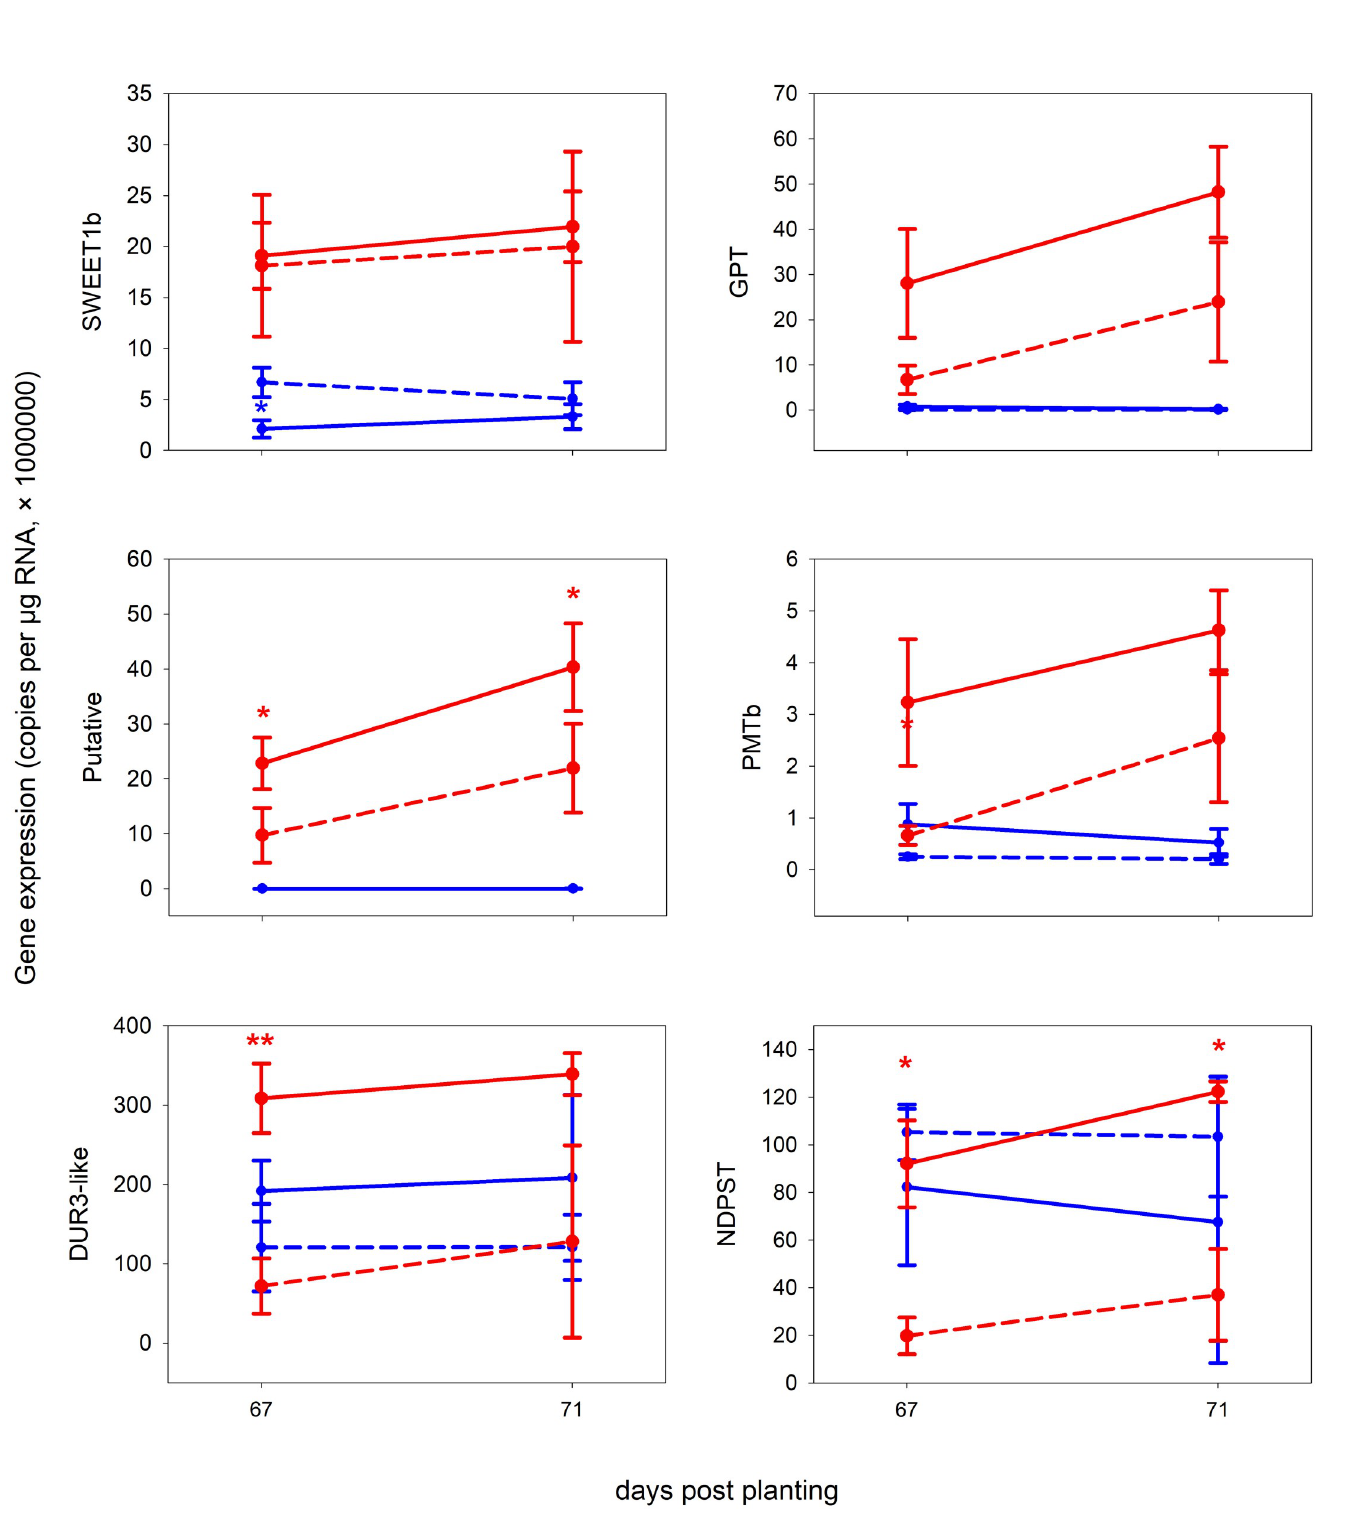
Fig 3. The expression of several genes obtained by qPCR from roots of M . truncatula in Exp 2. X-axis: days post planting, Y-axis: number of corresponding-gene copies per 1 μ g of RNA subjected to reverse transcription. Red: mycorrhizal, Blue: non-mycorrhizal, Full line: full light (100%), dashed-line: shaded plants (10% of light). Error bars show standard deviations, n = 3. For further details see Materials and methods and S2 Table. Asterisks indicate significance levels (p-value classes) as per t-test comparing non-shaded and shaded plants within the mycorrhizal (red) or non-mycorrhizal (blue) treatments: 0 < ��� < 0.001 � �� < 0.01 � � < 0.05. https://doi.org/10.1371/journal.pone.0224938.g003 PLOS ONE | https://doi.org/10.1371/journal.pone.0224938 November11, 2019 10 /